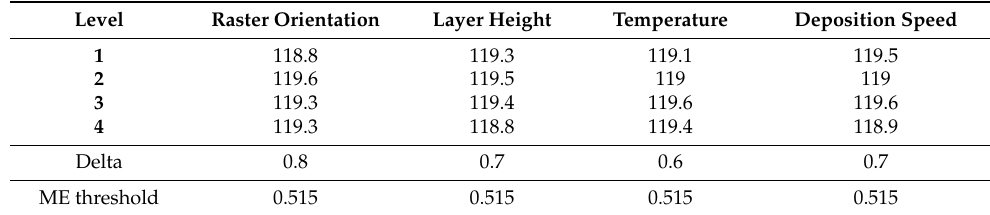
Table 5. Lenth’s method of factor analysis for glass transition temperature; the values shown correspond to the average of response under each corresponding level of the process factors. The physical values of the levels were given in Table